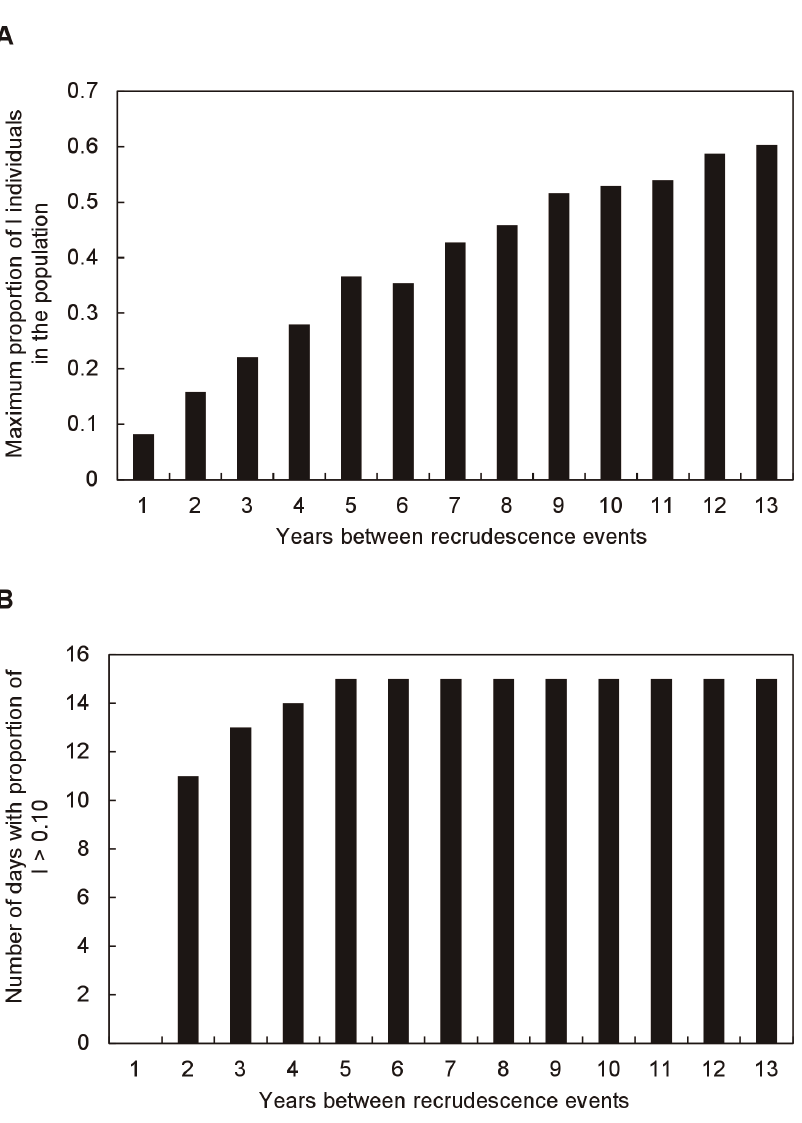
Figure 5. Simulated differences in the (A) magnitudes of epidemics (maximum proportion of I individuals in the population) and (B) durations of epidemics (number of days with proportion of I . 0.10) resulting from the indicated number of consecutive years without recrudescence between years with a high recrudescence rate.